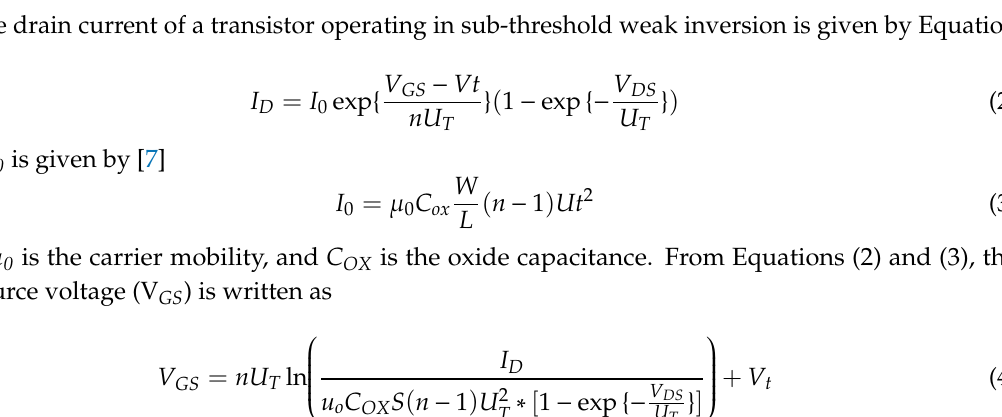
Figure 2. The self-cascode composite transistor (SCCT).